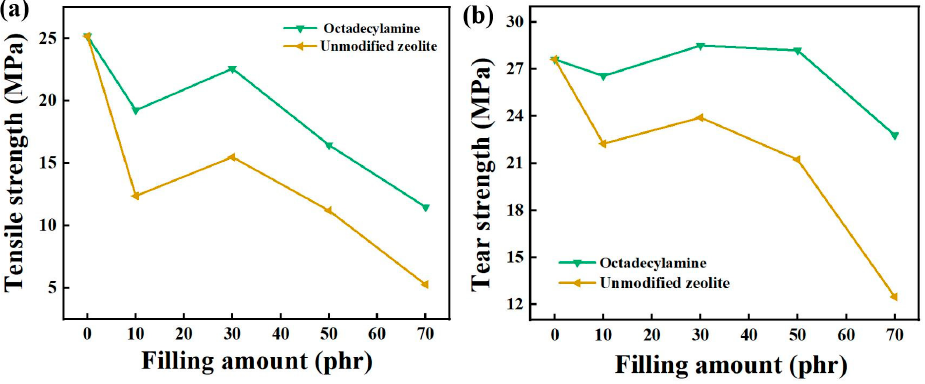
Figure 3. The effect of filling amount on tensile strength ( a ) and tear strength ( b ).